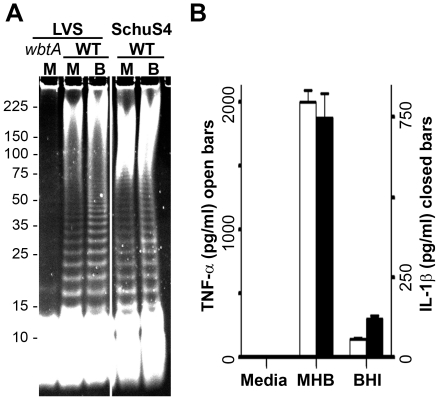
BHI-grown F. tularensis SchuS4 also displays increased production of HMW carbohydrate(s) and reduced cytokine elaboration.
F. tularensis LVS (WT and wbtA) and SchuS4 were grown in MHB (M) and BHI (B). A) Proteinase K-treated lysates were resolved through 8-16 % SDS-PAGE Protean II large gels and stained with Emerald green to visualize carbohydrates. B) Viable F. tularensis SchuS4, grown as indicated, were co-incubated with C57BL/6 BMDMs at an MOI of 100 for 24 hrs prior to analysis of secreted cytokine levels. Results are means and standard errors from three independent experiments each conducted in duplicate.